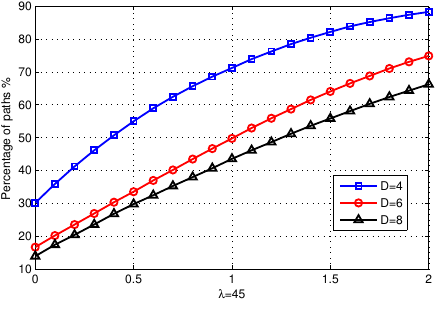
Figure 11. The cumulative distribution of the increased propagation delay for the topologies with λ =